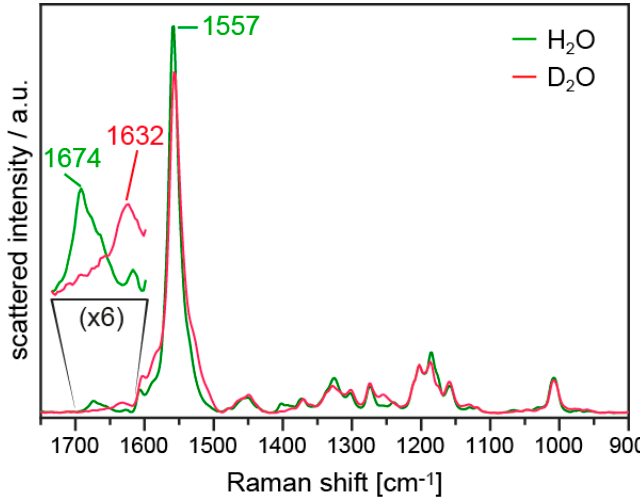
Figure 4. Resonance Raman spectra of the T127A variant in H 2 O (green trace) and in D 2 O (red trace). The indicated vibrational bands are discussed in the text.